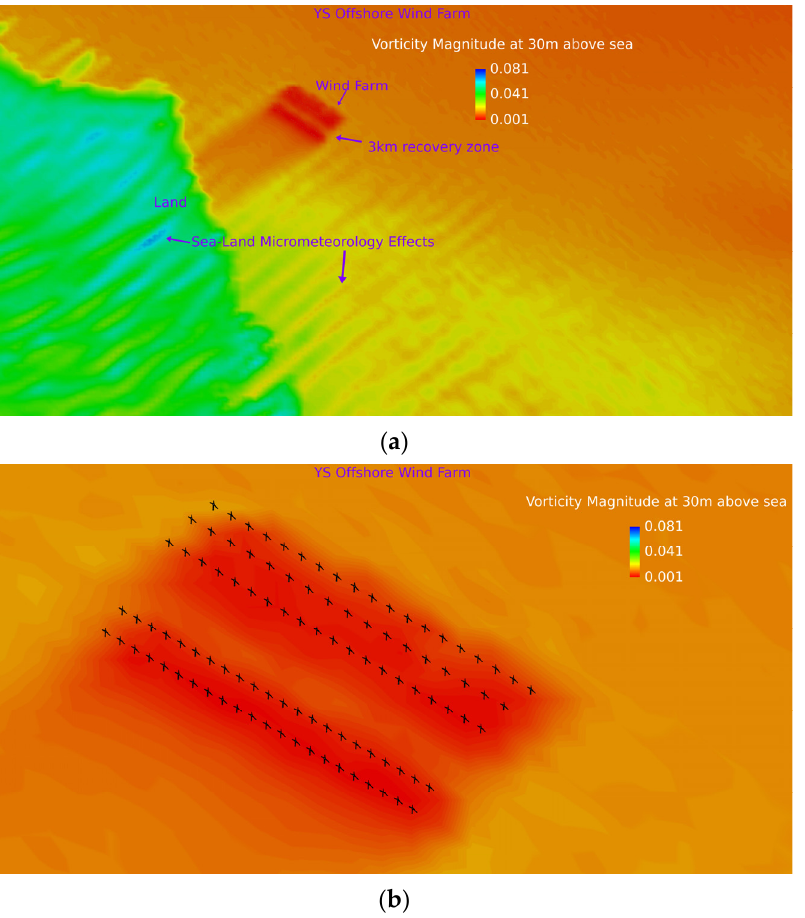
Figure 11. The diagram of vorticity magnitude at 30 m above the sea with an about 10 m/s inflow velocity under Case III: ( a ) the vorticity magnitude on the land and sea; ( b ) the vorticity magnitude around the wind farm.